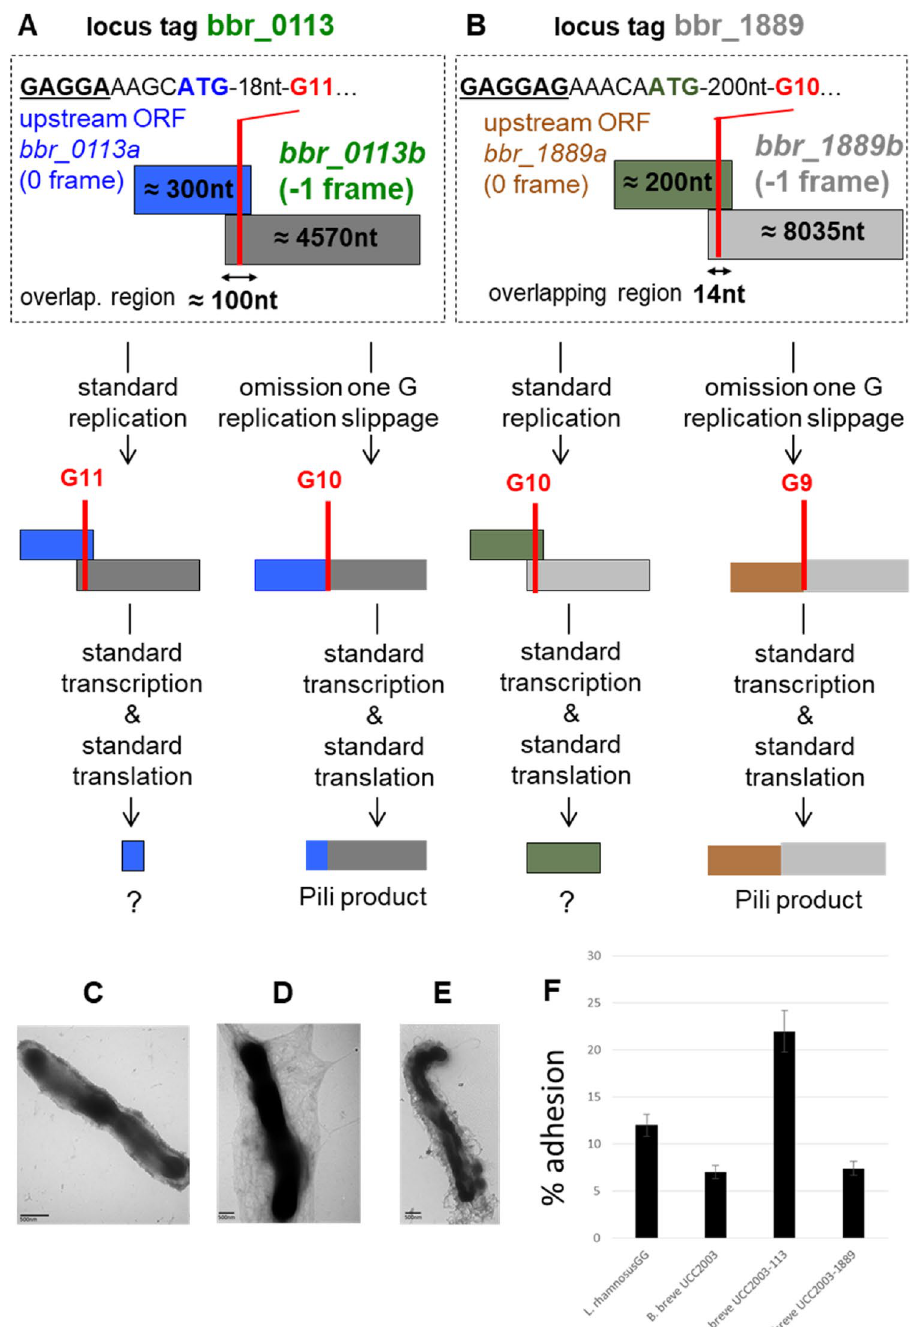
Figure 2. Phenotype and biological activity. A schematic of the expression of Bbr_0113ab and Bbr_1889ab pilus products derived by replication slippage is indicated in ( A ) and ( B ) where ORFs are indicated by a rectangle, for bbr_0113 locus ( A ) with bbr_0113a (in blue) and bbr_0113b (in green), for bbr_1889 locus ( B ) with bbr_1889a (in brown) and bbr_1889b (in grey). Above is indicated a presumably initiation of translation encompassing the translational codon for bbr_0113a and bbr_1889b (indicated in same color as their ORF) and a potential Shine-Dalgarno sequence (underlined). Below is shown the impact of standard or adequate replication slippage causing, respectively, the expression of a truncated or complete pilus product. Expression of sortase-dependent pili by recombinant strains of ( C ) B. breve UCC2003, ( D ) UCC2003-113 or ( E ) UCC2003- 1889. Cells were stained with ammonium molybdate and visualized by transmission electron microscopy. Biological functionality of pili in cell interaction of ( F ) B. breve UCC2003, UCC2003-113, UCC2003-1889 to HT29 cells as determined by the viable count method. Data presented are an average of triplicate experiments. L. rhamnosus GG was included as a